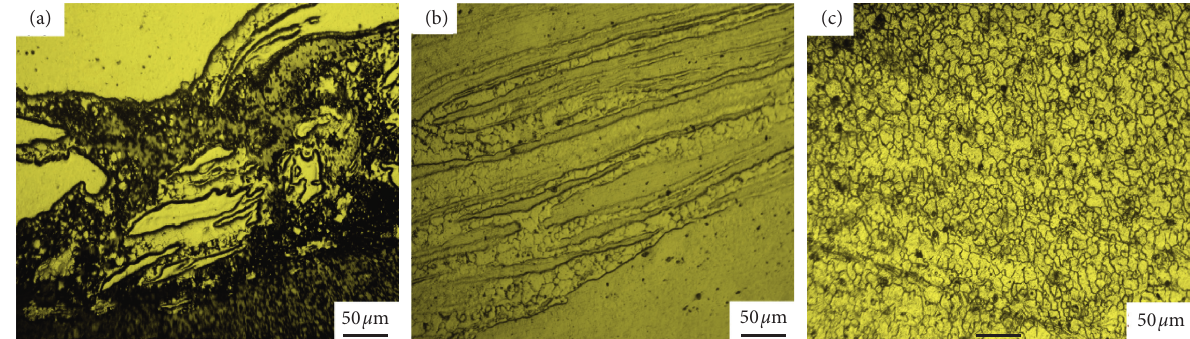
Figure 12: Typical images (OM) of microstructure: (a) the IS with 30mm/min; (b) the LS with 50mm/min; (c) the ES with 65 mm/min.